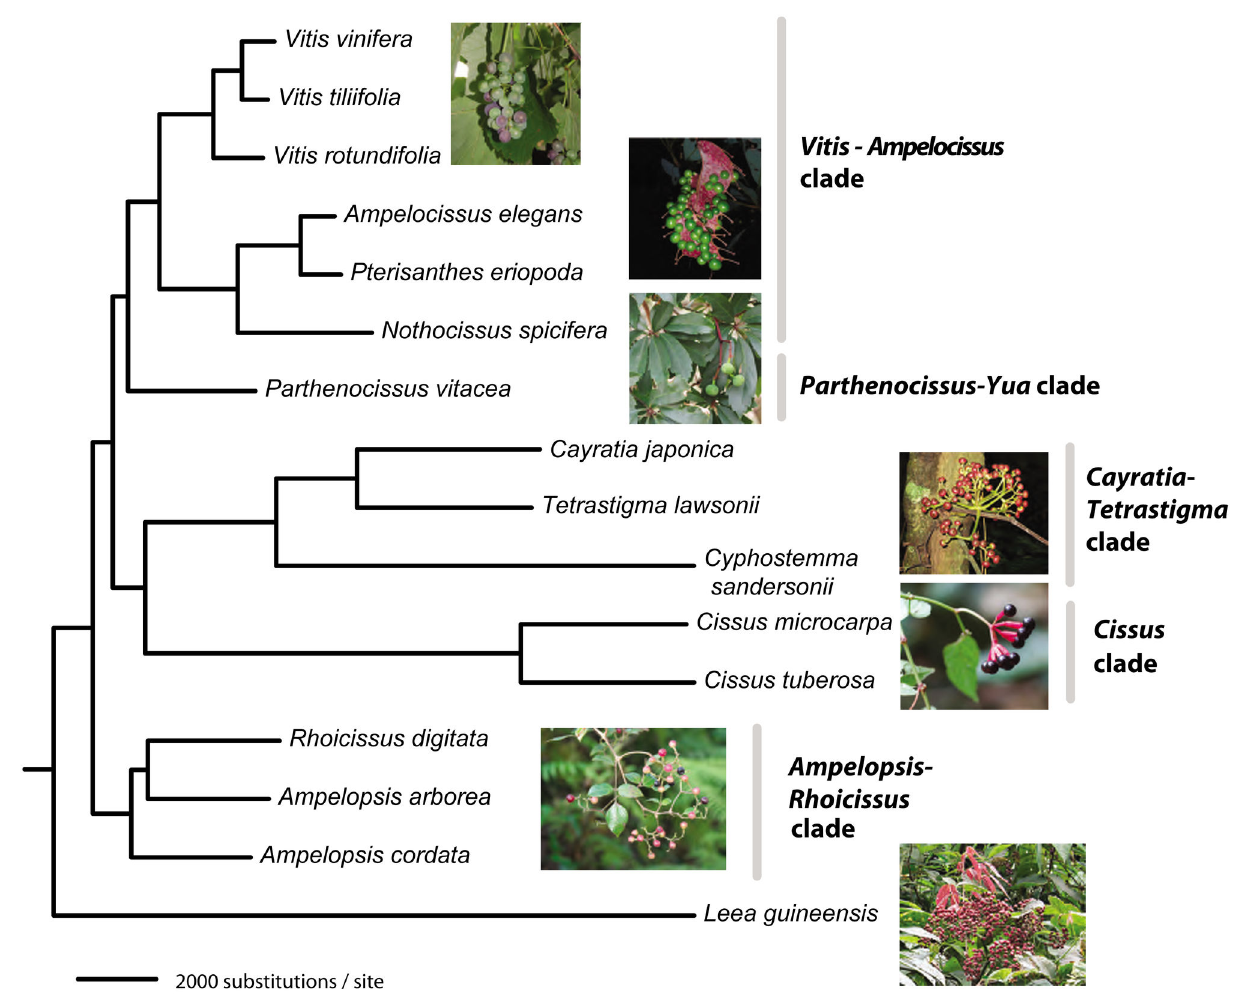
Figure 1. Maximum likelihood tree of Vitaceae using nucleotide sequences of 229 genes from the 15 transcriptomes of Vitaceae. The same topology was recovered from the 417 gene data set. Bootstrap support for all nodes was 100%, and posterior probabilities in the Bayesian inference for all nodes were